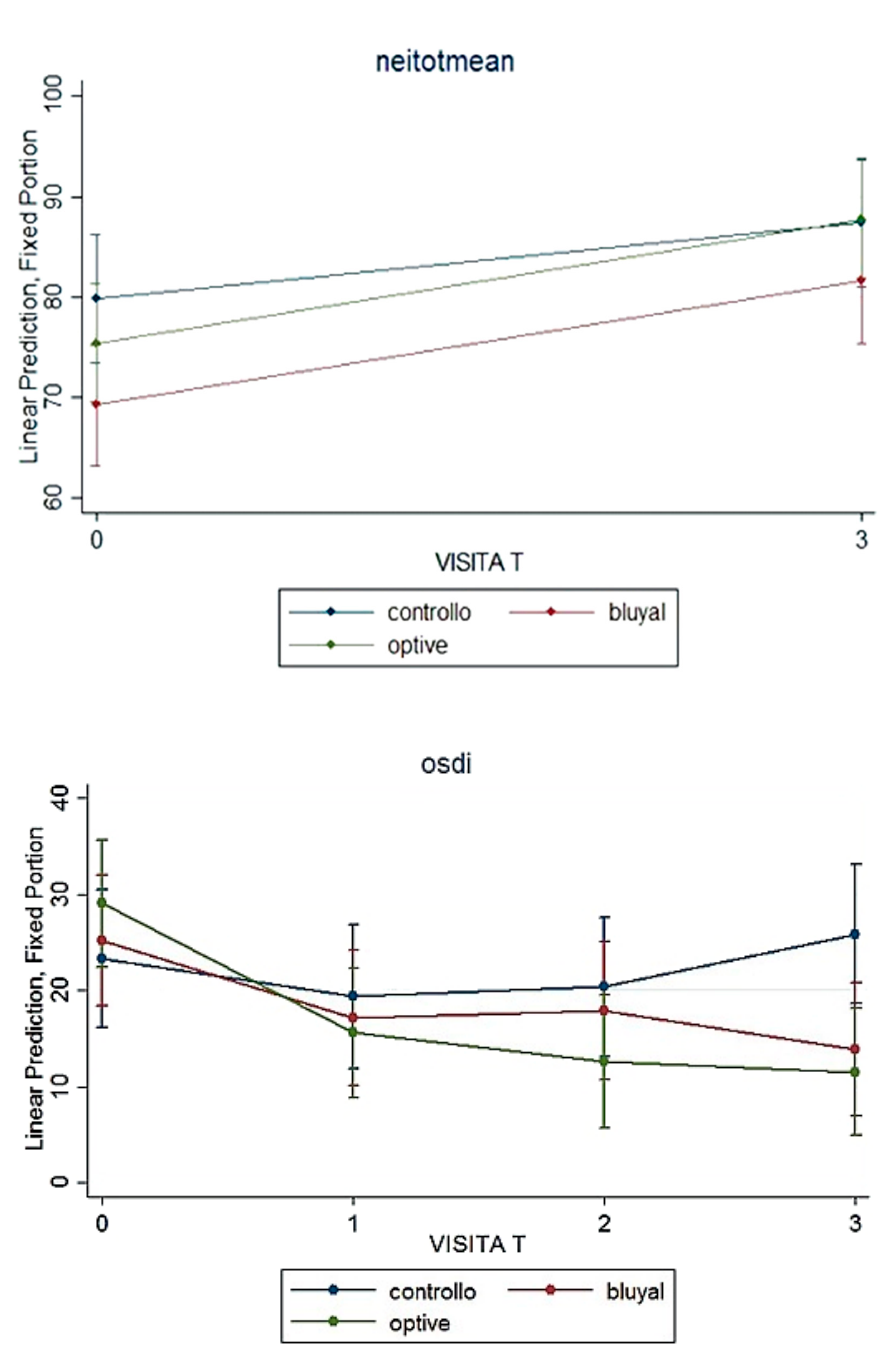
Figure 3. Symptoms and quality of life: NEI-VFQ total mean scoe and OSDI over the time in the three groups.